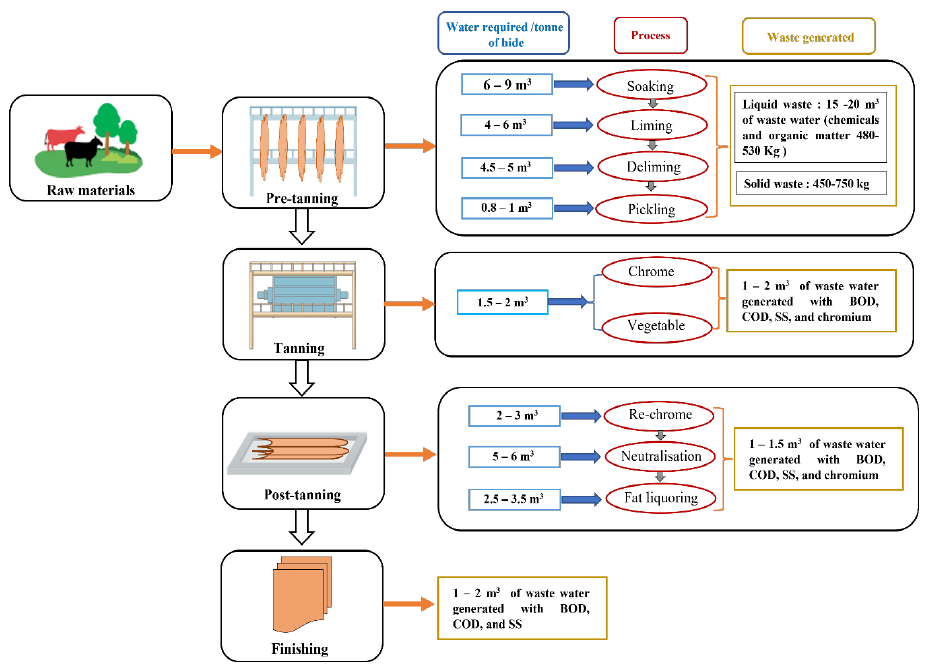
Figure 2. Stages of the leather manufacturing sector with wastewater generated in each of them. TWW is highly toxic and has serious impacts on the soil by acidification, reducing soil fertility, leaching chromium into the deeper layer of soil, and altering the soil micro- bial communities. In surface water, TWW causes foaming, blocks sunlight penetration, and affects aquatic life by depleting dissolved oxygen in the water, triggering eutrophi- cation, and increasing salinity in water [21,22]. TWW also causes several serious prob- lems in living organisms, such as hematotoxicity in the common fish Tilapia mossambica and Labeo rohita, altered oxidative enzymes in Poecilia reticulata, embryonic toxicity to zebrafish, disrupted physiological and cytological processes in plants, hormonal imbal- ance, compromised reproductive fitness in rats, acute embryotoxicity in sea urchins, and genotoxic effects in the snail Pila globose [23] .